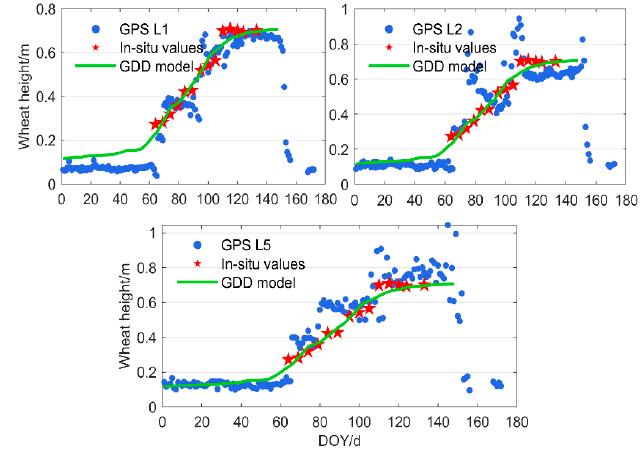
Figure 11. Wheat height retrieval with the GPS system using segmented processing. The relative wheat height retrievals of the L1 frequency band using the segmented processing method are compared with the in situ height observations in Table 2. There are no in situ measured values at the beginning and after harvest; only a comparison of wheat height after the heading stage is shown here. Table 2. Relative deviations of L1 frequency band between wheat height retrievals, in situ observations and GDD model.